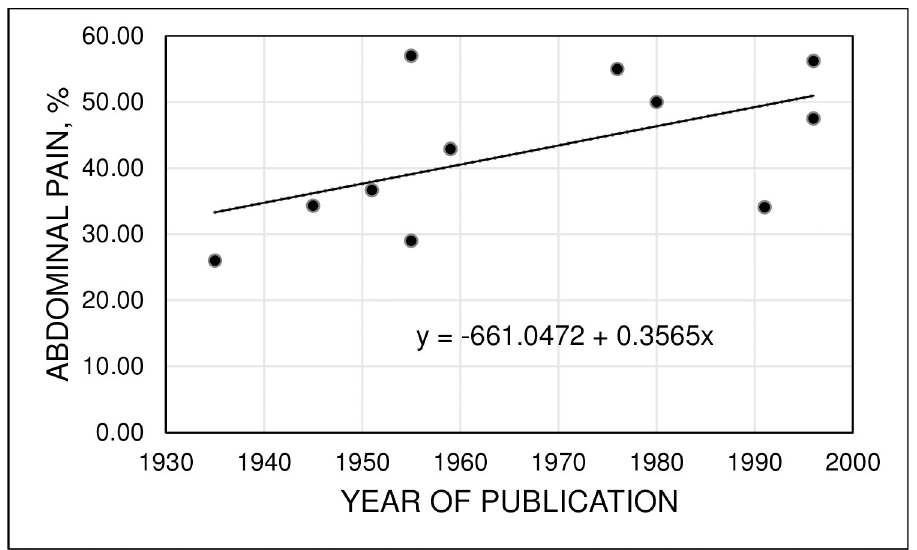
Fig 2. Hemochromatosis and abdominal pain. Percentages of adults with hemochromatosis diagnosed in referral venues who reported abdominal pain at diagnosis in 11 reports published during the interval 1935–1996 [3,19– 26,42,49].Pearson correlation coefficient 0.5491; adjusted r 2 = 0.2239 (p = 0.0802).